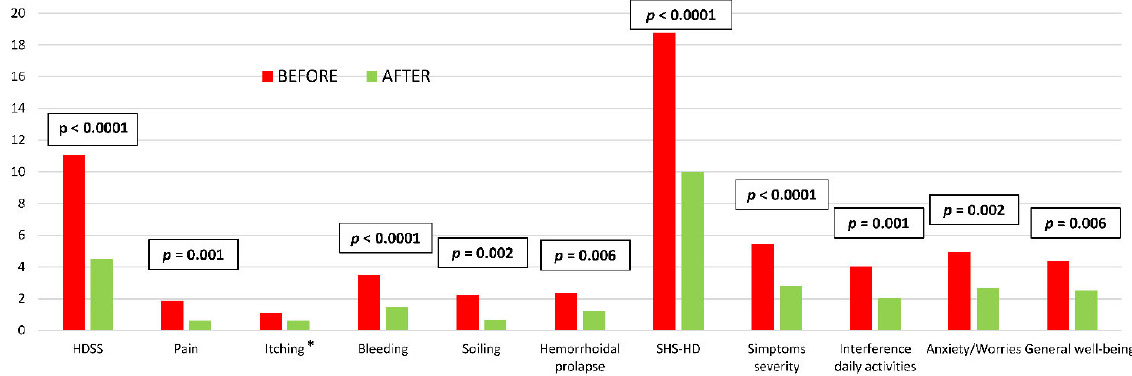
Figure 2. Comparison between HDSS and SHS ‐ HD scores collected before Emborrhoid technique and at last follow ‐ up visit (Wilcoxon test). * p = 0.111 . HDSS = Hemorrhoidal Disease Symptoms Score; SHS ‐ HD = Short Health Scale for Hemorrhoidal Disease.